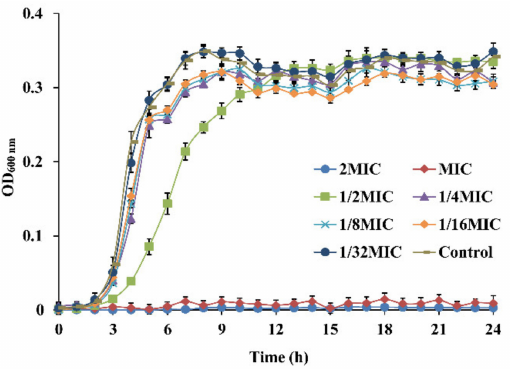
Figure 1. E. faecalis ATCC 29212 growth curves in BHI broth with different concentrations of OEO.